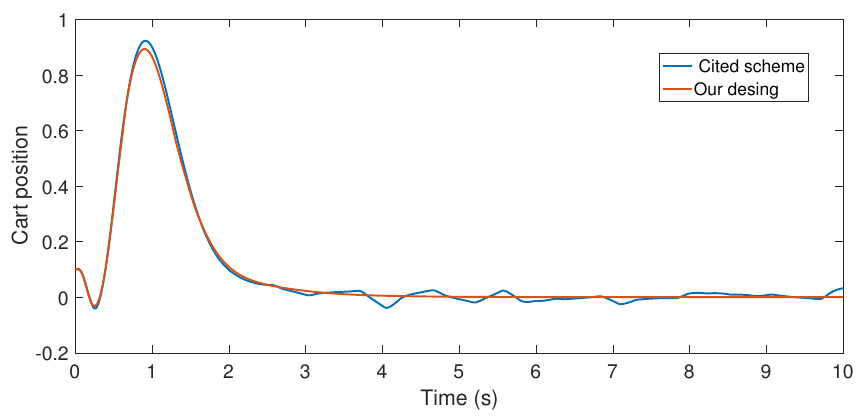
Figure 3. Numerical experiment results: cart position (m).